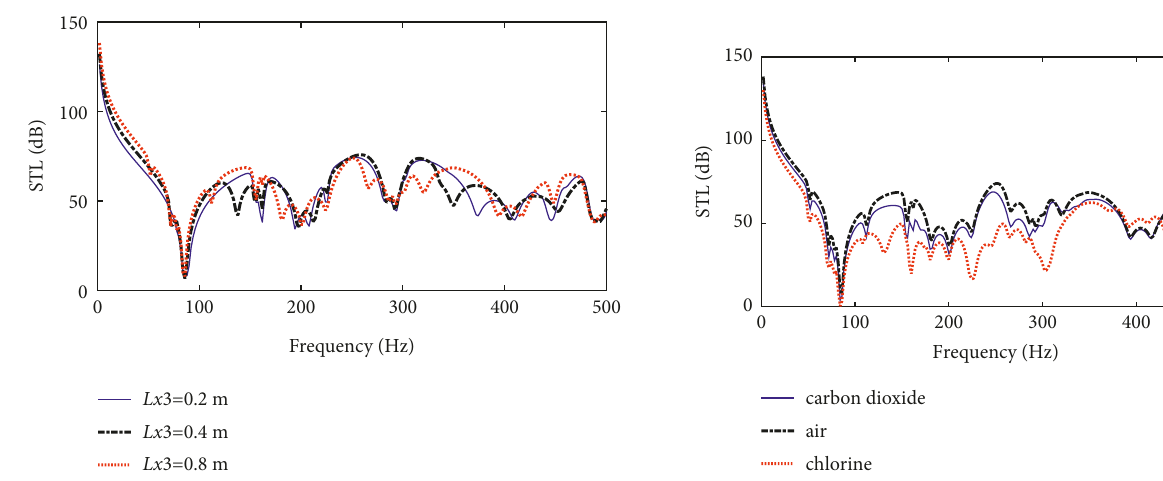
Figure 21: Sound transmission loss of the stiffened double panel- cavity coupled system with different acoustic cavity mediums.